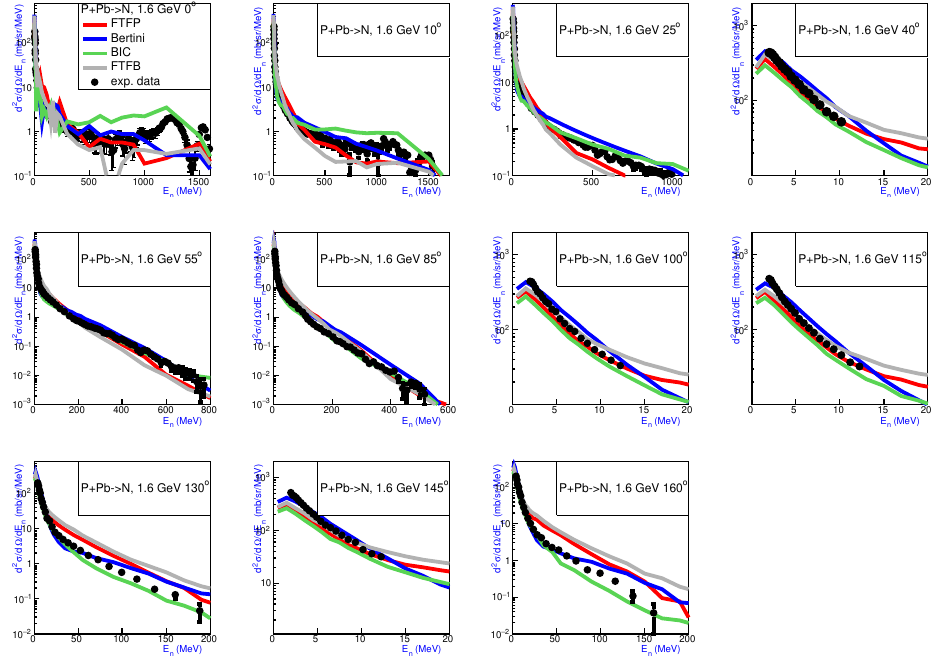
Figure 3. Inclusive cross sections of neutrons produced in p + Pb interactions at projectile energy 1.6 GeV at various emission angles of neutrons. Points are the experimental data [4]. Lines are calculations by the FTFP, FTFB, Bertini, Binary cascade